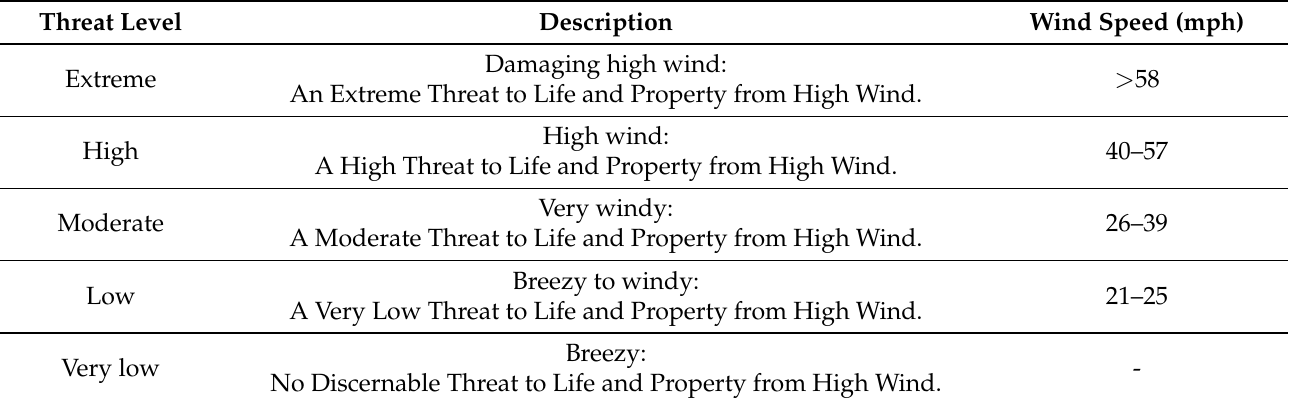
Table 2. Wind threat threshold as defined by NOAA. Source: Adapted from NOAA